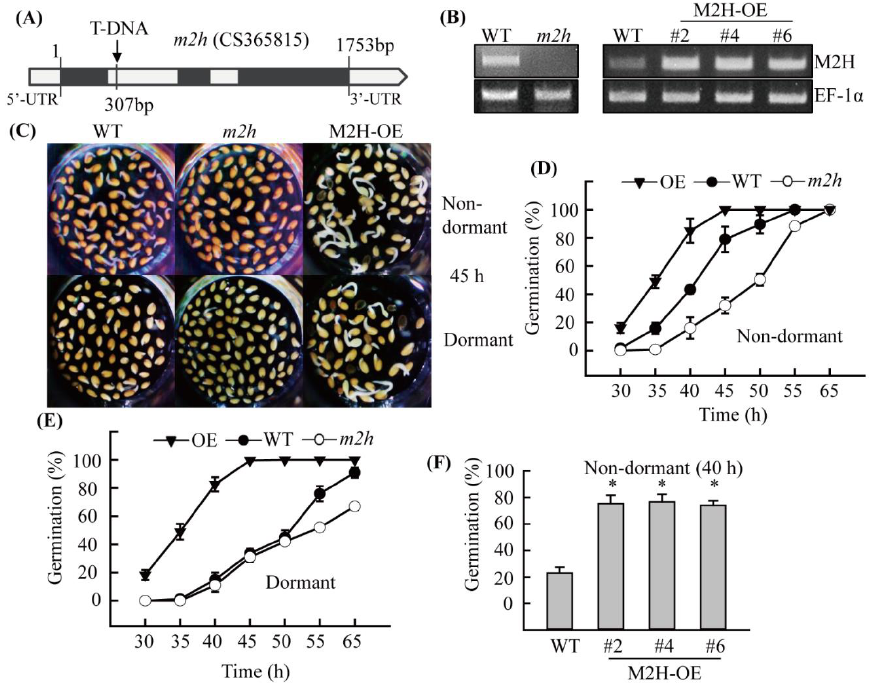
Figure 4. Germination results for m2h knockout mutant and M2H overexpression A . thaliana seeds. ( A ) Diagram of T-DNA insertion into M2H knockout A . thaliana ( m2h ). Black and white boxes indicate introns and exons, respectively. Arrows indicate the location of T-DNA insertion (not to scale). ( B ) Expression levels of M2H by RT-PCR in 7-week-old WT, m2h knockout , and M2H overexpression (M2H-OE) plants. Radical protrusion was photographed ( C ) at 45 h, and the germination ratio was quantified at various incubation times in ( D ) non-dormant seeds and ( E ) dormant seeds. ( F ) Seed